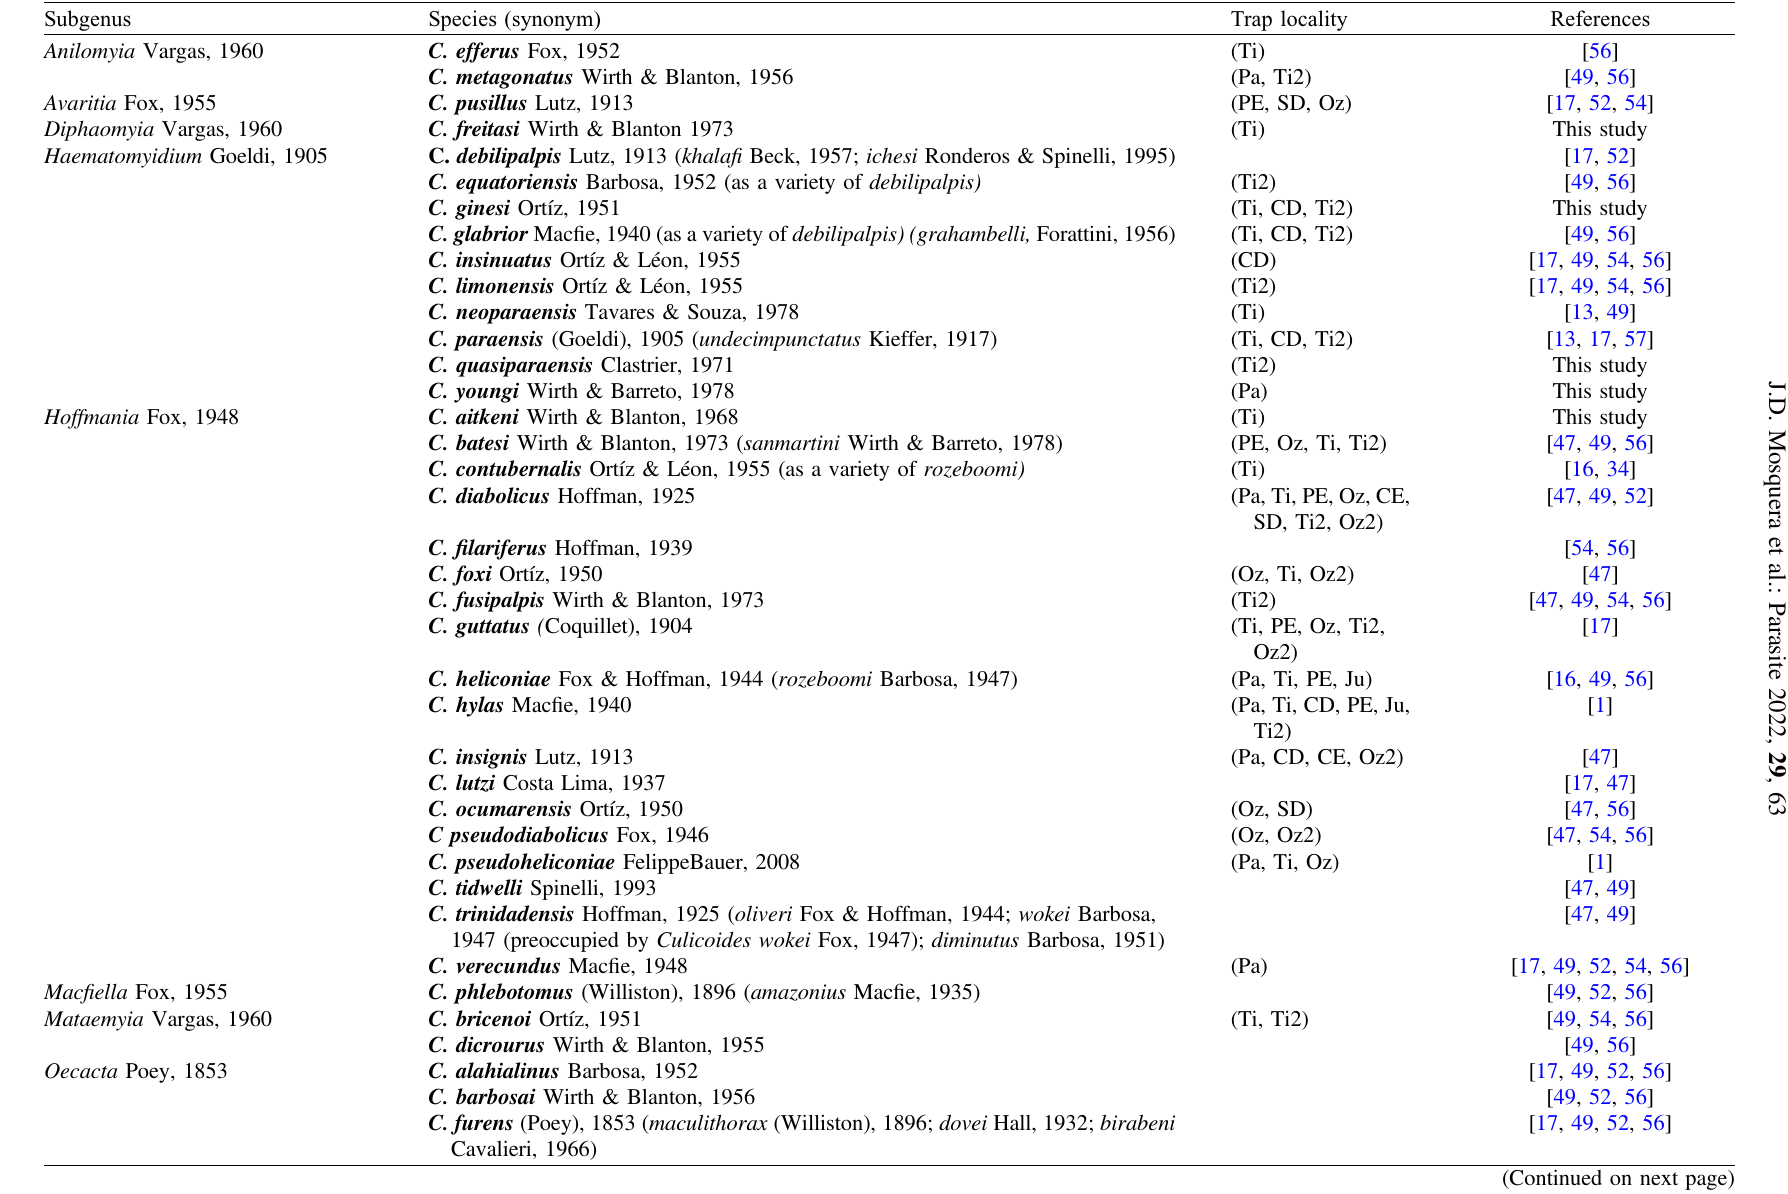
Table 1. Culicoides species list for